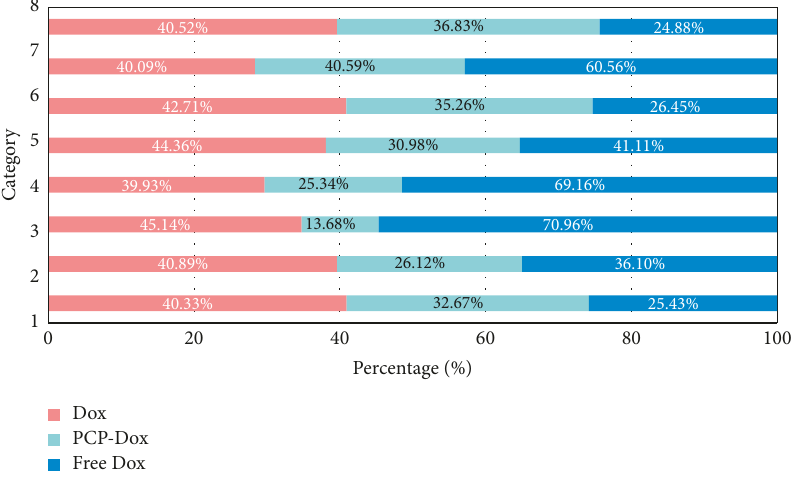
Figure 4: Cytotoxicity test